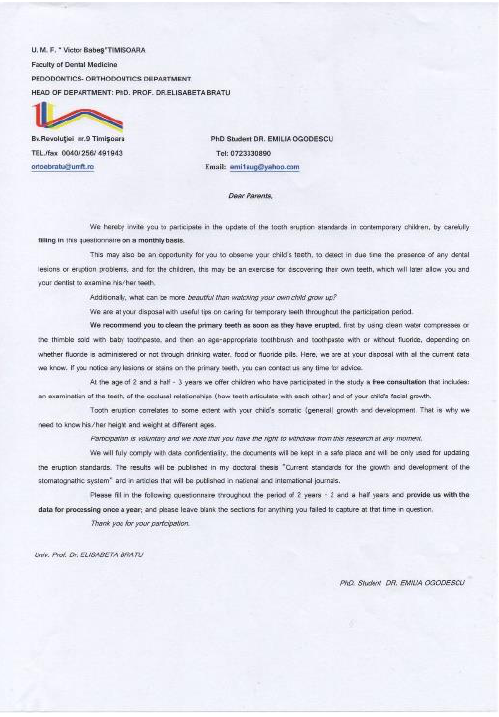
Figure A1. First page of the questionnaire (presentation of the study for the